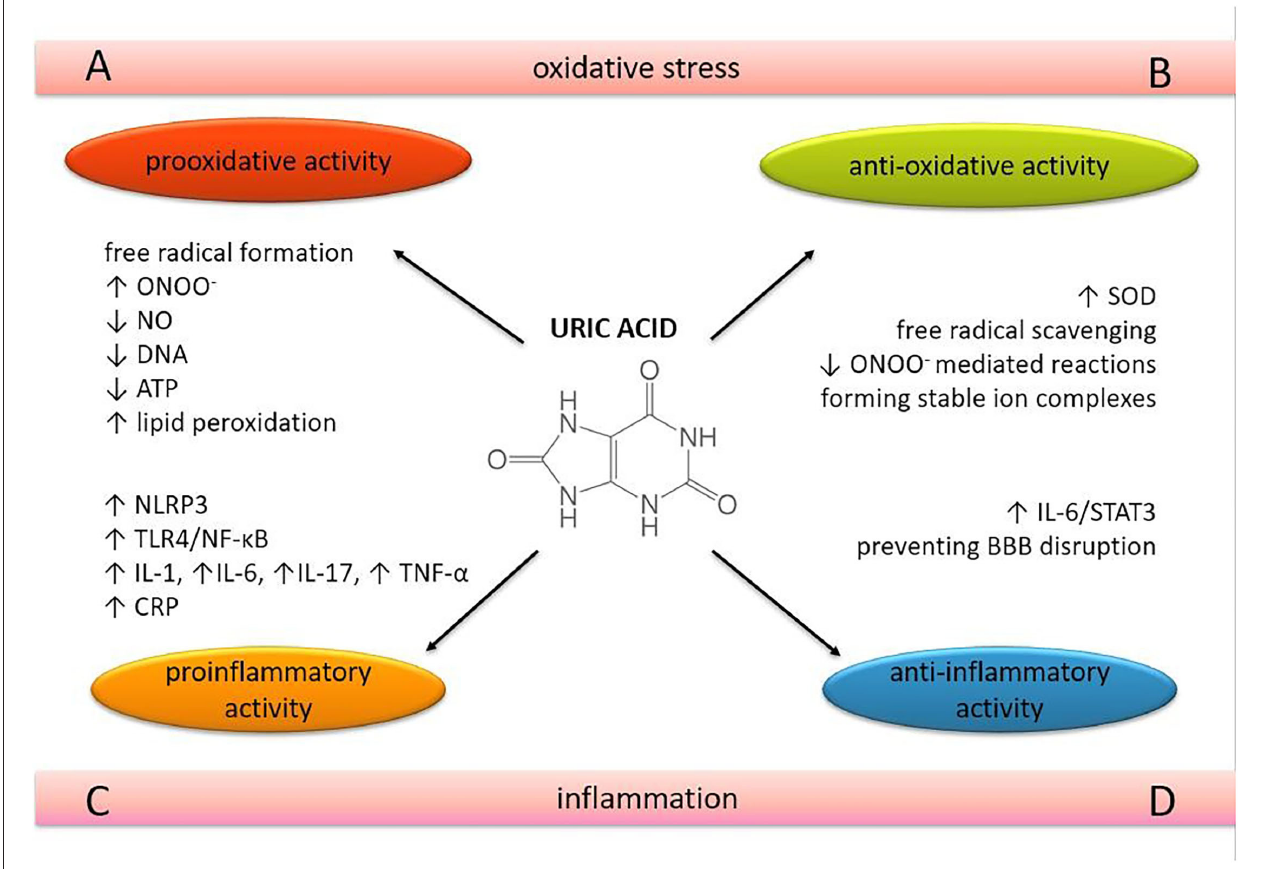
FIGURE 1 | The role of uric acid in oxidative stress and neuroinflammation. The dual nature of uric acid in terms of oxidative and inflammatory processes in brain tissue. ONOO − , peroxynitrite; NO, nitric oxide; SOD, superoxide dismutase; DNA, deoxyibonucleic acid; oxidative (A,B) and inflammatory processes. (C,D) in brain tissue. ATP, adenosine 5’-triphosphate; NLRP3, nucleotide-binding and oligomerization domain-like receptor protein 3; TLR4, Toll-like receptor 4; NF- κ B, nuclear factor kappa-light-chain-enhancer of activated B cells; IL, interleukin; TNF- α , tumor necrosis factor-alpha; CRP, C-reactive protein; STAT 3, signal transducer and activator of transcription 3; BBB, blood-brain